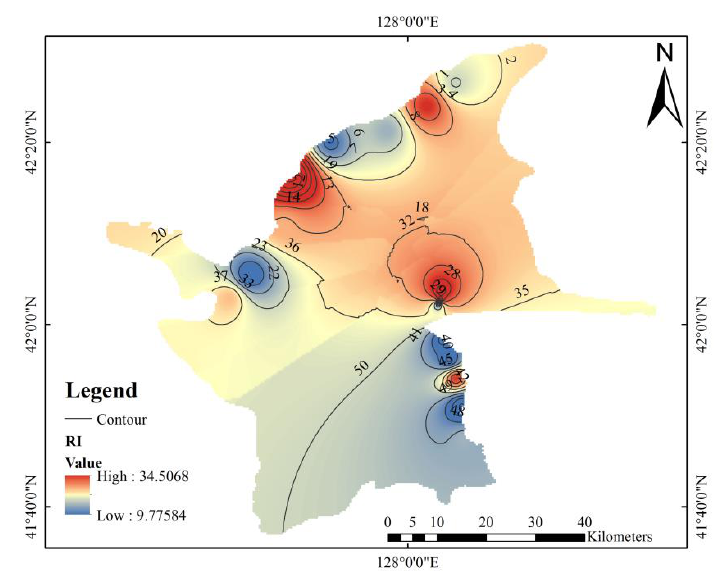
Figure 7. Spatial distribution of potential ecological risk index (RI) in Changbai Mountain.